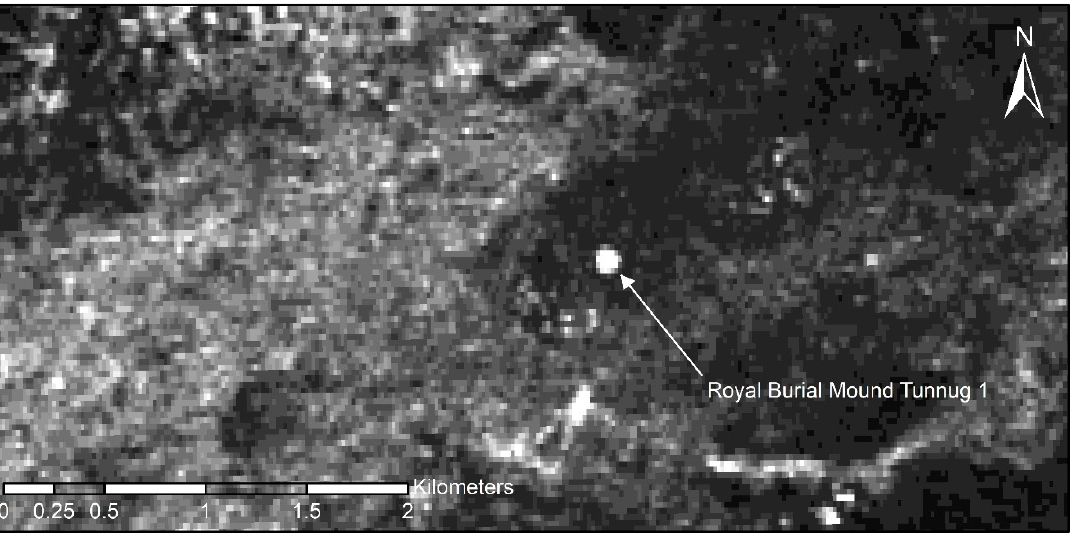
Figure 3. ALOS-2 data (HV polarization) showing clearly that in the larger vicinity of the mound no monuments of equal size and composition can be found.